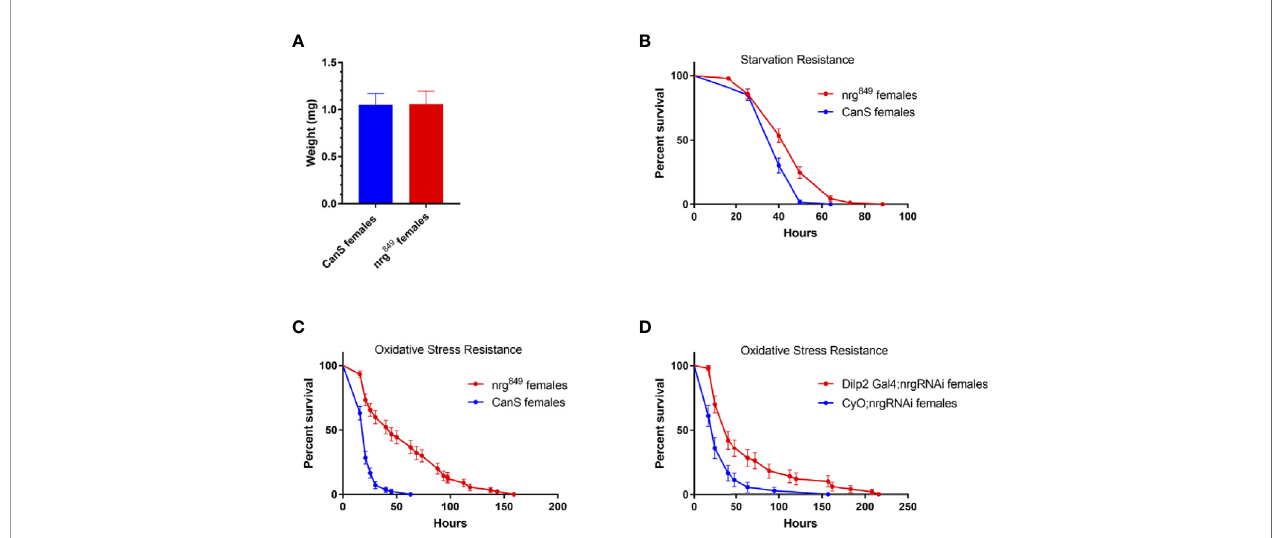
FIGURE 2 | Loss of Nrg results in phenotypes associated with disrupted insulin signaling. (A) While there is no difference in nrg 849 animal size (P=0.790, Mann Whitney U test), nrg 849 mutants are more resistant to (B) starvation (P=0.0005, log-rank test; wildtype median survival = 40 hours, nrg 849 median survival = 49.75 hours) and (C) oxidative stress (P < 0.0001, log-rank test; wildtype median survival = 21 hours, nrg 849 median survival = 45 hours). Similarly, IPC-speci fi c knockdown of nrg also results in increased resistance to (D) oxidative stress (P < 0.0001, log-rank test; wildtype median survival = 24 hours, Dilp2 Gal4:nrg RNAi median survival = 39.5